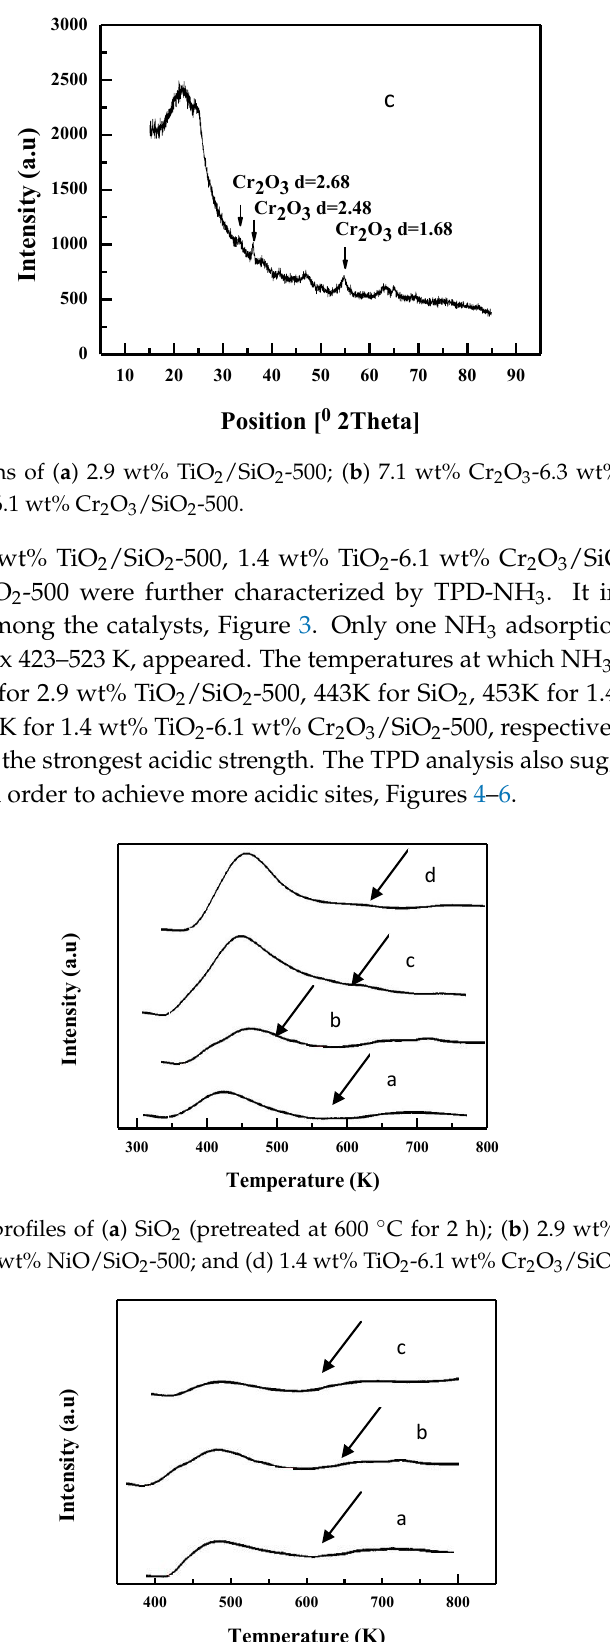
Figure 4. NH 3 -TPD profiles of ( a ) 2.9 wt% TiO 2 /SiO 2 -400, ( b ) 2.9 wt% TiO 2 /SiO 2 -500; and ( c ) 2.9 wt% TiO 2 /SiO 2 -600.